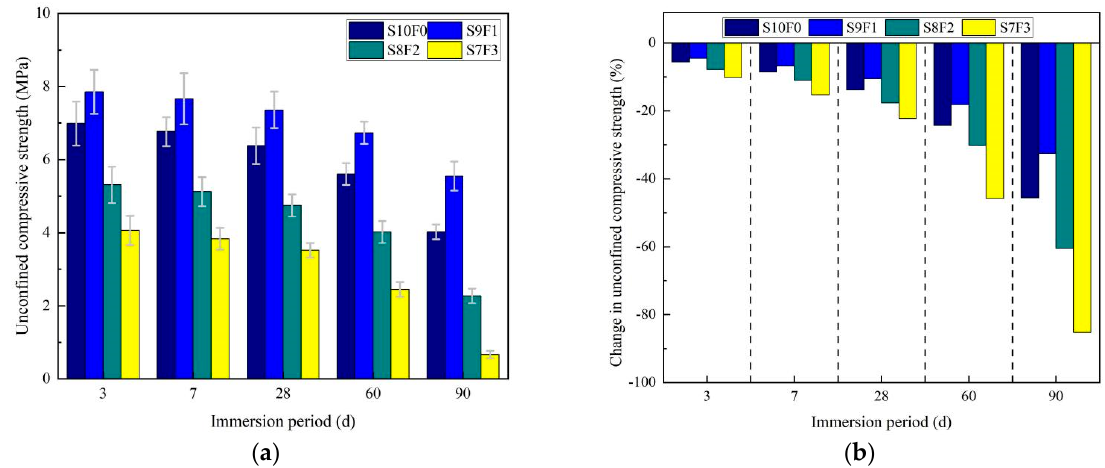
Figure 6. ( a ) The UCS of SF-GSSS immersed in MgSO 4 solution at various times. ( b ) Change in